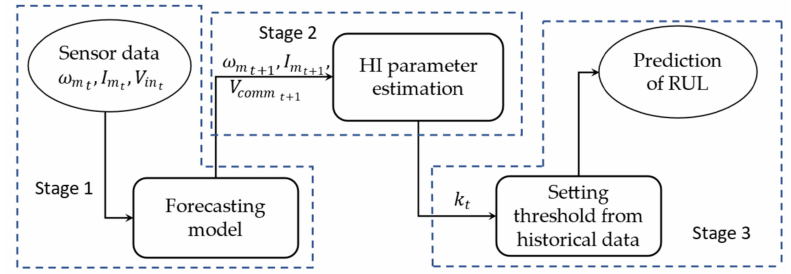
Figure 1. Steps towards prognosis of satellite